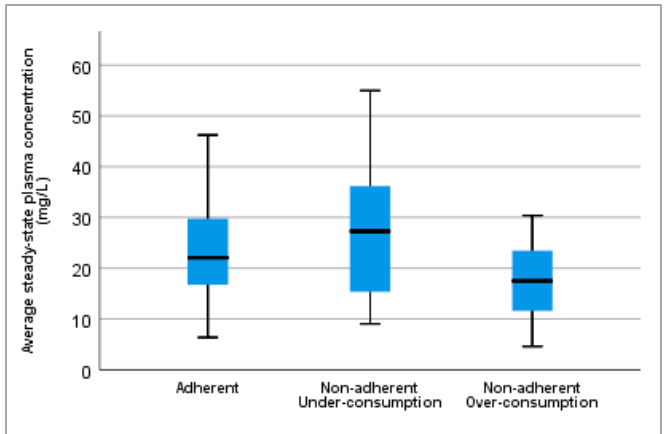
Figure 4. Average steady-state plasma concentration of levetiracetam in each group of patients previously classified according to adherence. Statistically significant differences ( p = 0.041) were observed between non-adherent under-consumers and non-adherent over-consumers. Results are expressed as median and 25th and 75th quartiles. Black lines represent the median and blue blocks the 25th and 75th quartiles. Error bars represent 1.5 times the interquartile range from the 25th and 75th quartiles.